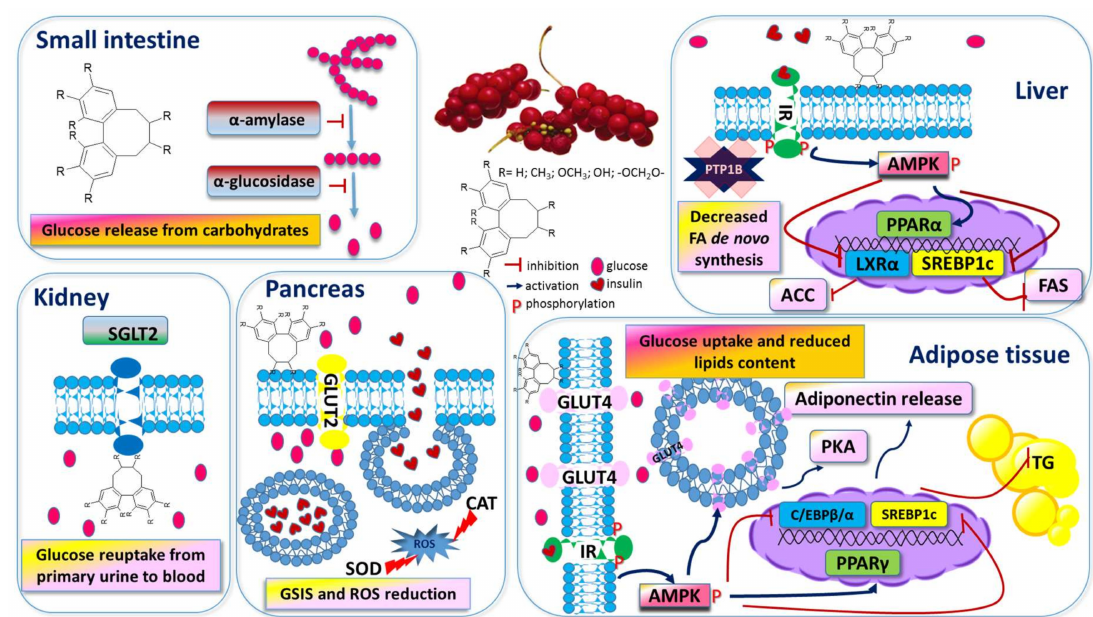
Figure 2. Proposed molecular mechanisms of anti-diabetic and anti-obesity actions of Schisandra chinensis in different organs and adipose tissue. See main text for more details. ACC—acetyl-CoA